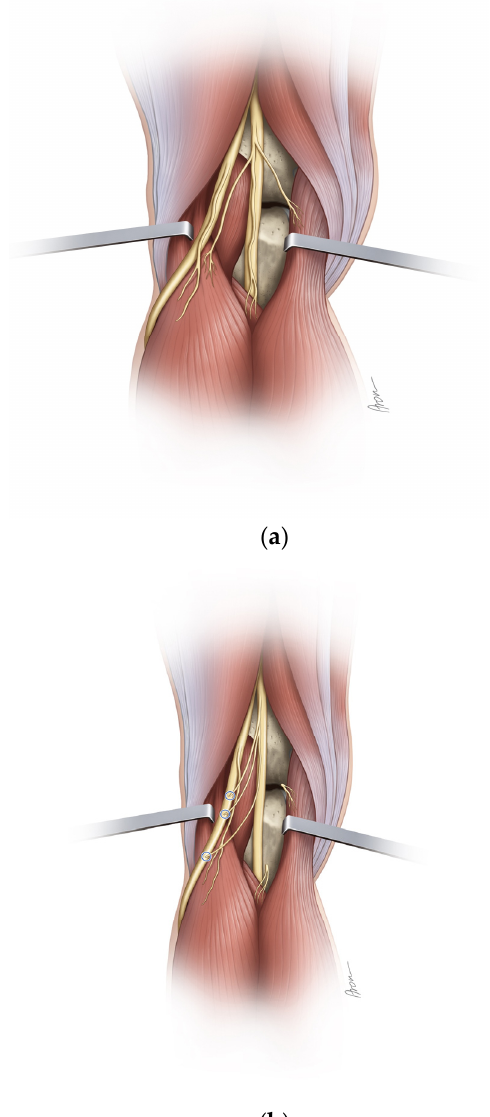
Figure 1. ( a , b ) Schematical illustration of the different nerve transfers in correlation to the femorotibial joint as well as the fibular head before ( a ) and after ( b ) transfer.